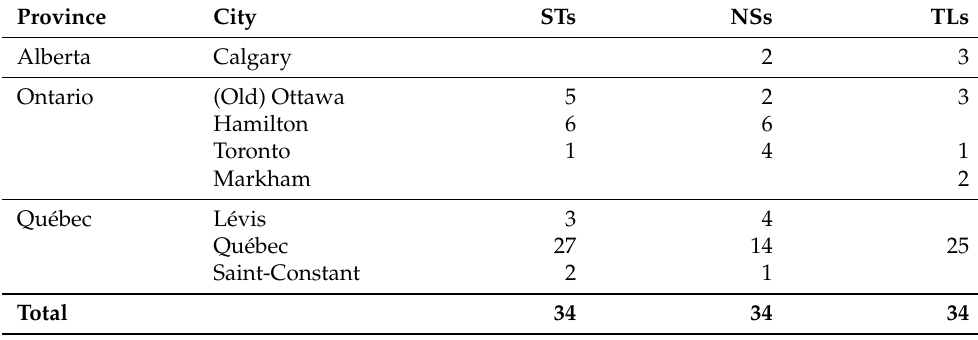
Table 1. TCEs junction count per city.